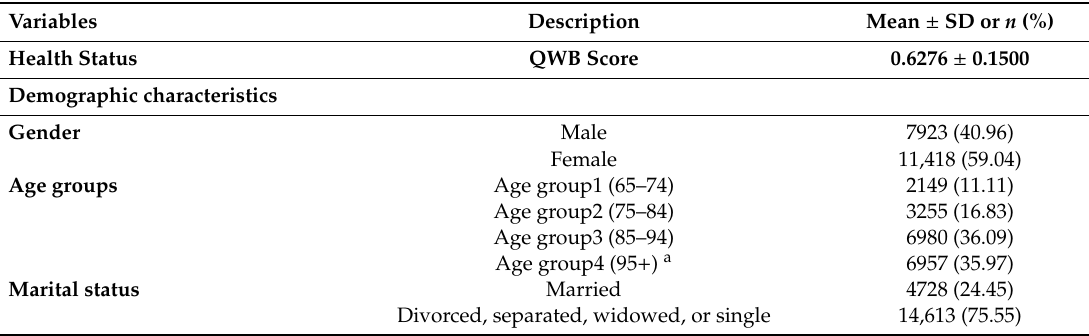
Table 3. Descriptive statistics of the main